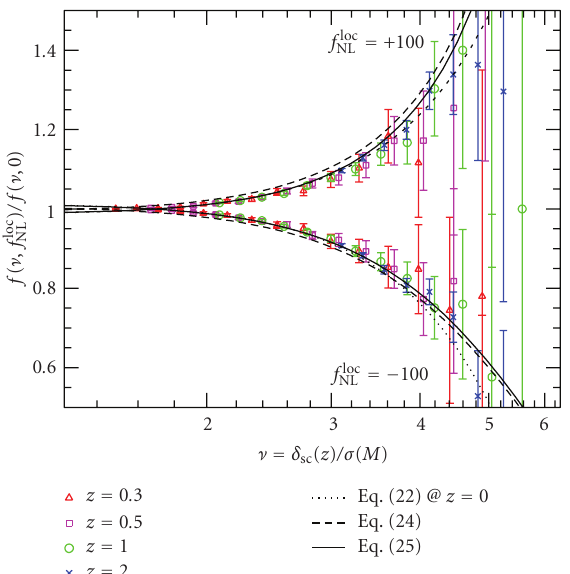
Figure 4: Fractional deviation from the Gaussian mass function as a function of the peak height ν = δ c /σ . Di ff erent symbols refer to di ff erent redshifts as indicated. The various curves are theoretical prediction at z = 0 (see text). Halos were identified using a spherical overdensity (SO) finder with a redshift-dependent overdensity threshold Δ vir ( z ) (with Δ vir ( z ) increasing from ∼ 200 at high redshift to attain ∼ 350 at z = 0). Error bars denote Poisson errors. For illustration, M = 10 15 M (cid:14) /h corresponds to a significance ν = 3 . 2, 5.2, 7.7 at redshift z = 0, 1 and 2, respectively. Similarly, M = 10 14 M (cid:14) /h and 10 13 M (cid:14) /h correspond to ν = 1 . 9, 3, 4.5 and 1.2, 1.9, 2.9, respectively.